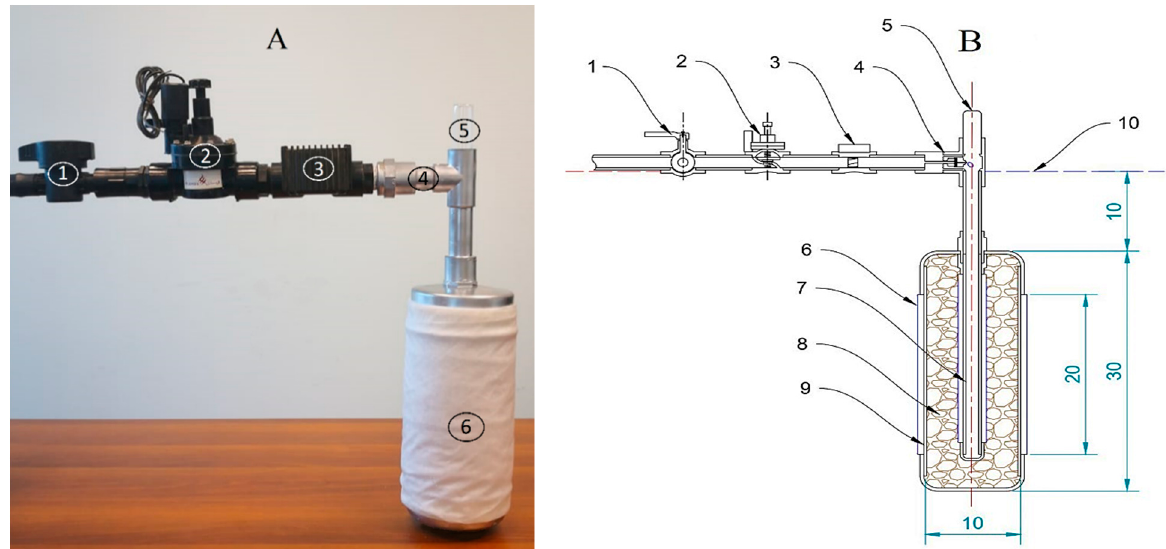
Figure 2. Image ( A ) and schematic diagram ( B ) of the subsurface irrigation unit. (1) Manual valve, (2) Electronic valve, (3) Digital flowmeter, (4) Twistable dripper head, (5) Glass cover, (6) Filtering cloth of the outer pipe, (7) The inner pipe, (8) Light volcanic gravel, (9) Slotted outer pipe (10) Soil level. All dimensions are in centimeters.